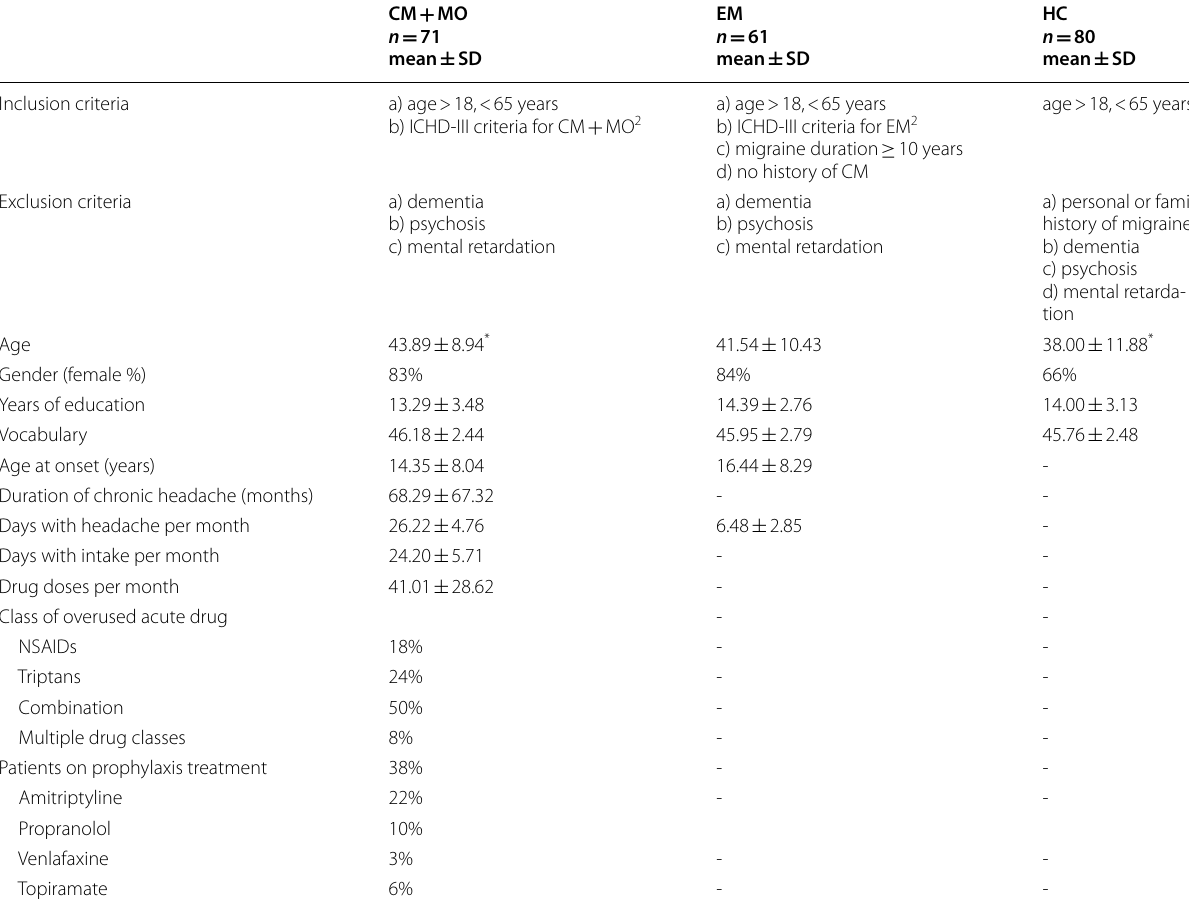
Table 1 Demographic and clinical characteristics of patients enrolled in the